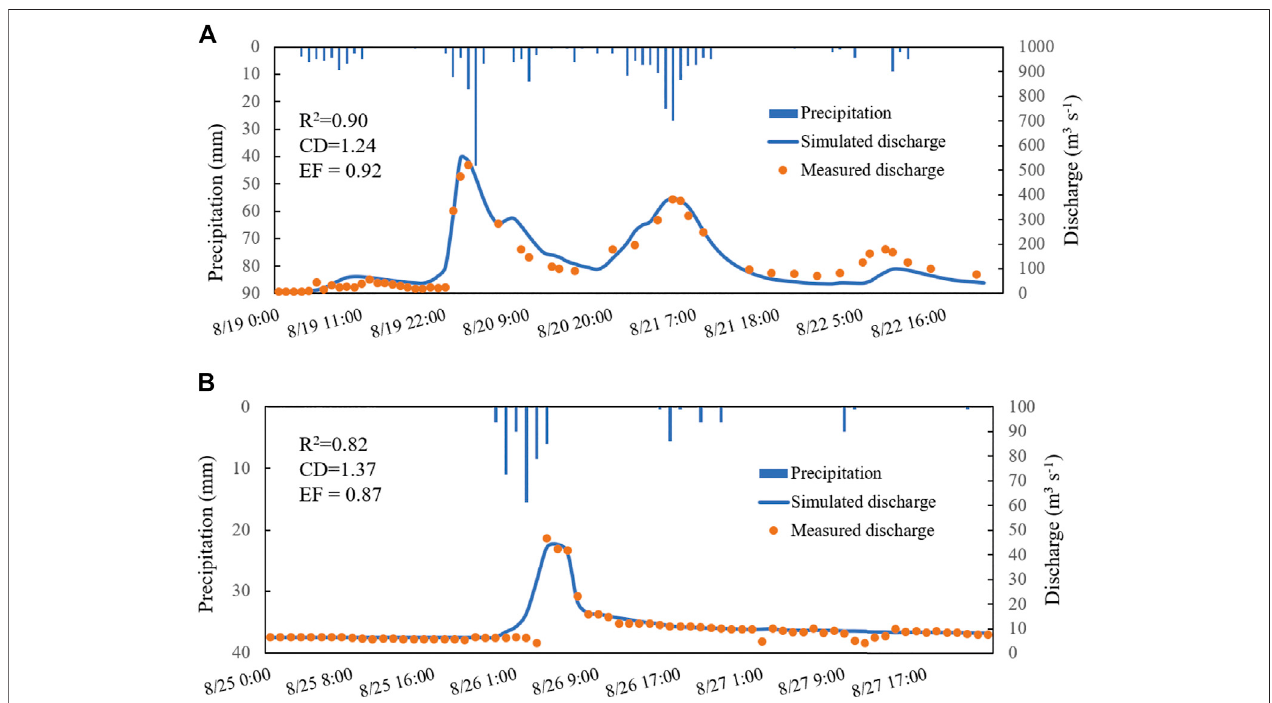
FIGURE 2 | Model performance of (A) calibration of fl ooding on August 20, 2019, and (B) validation of fl ooding on August 26, 2016. EF: modeling ef fi ciency. CD: coef fi cient of determination.